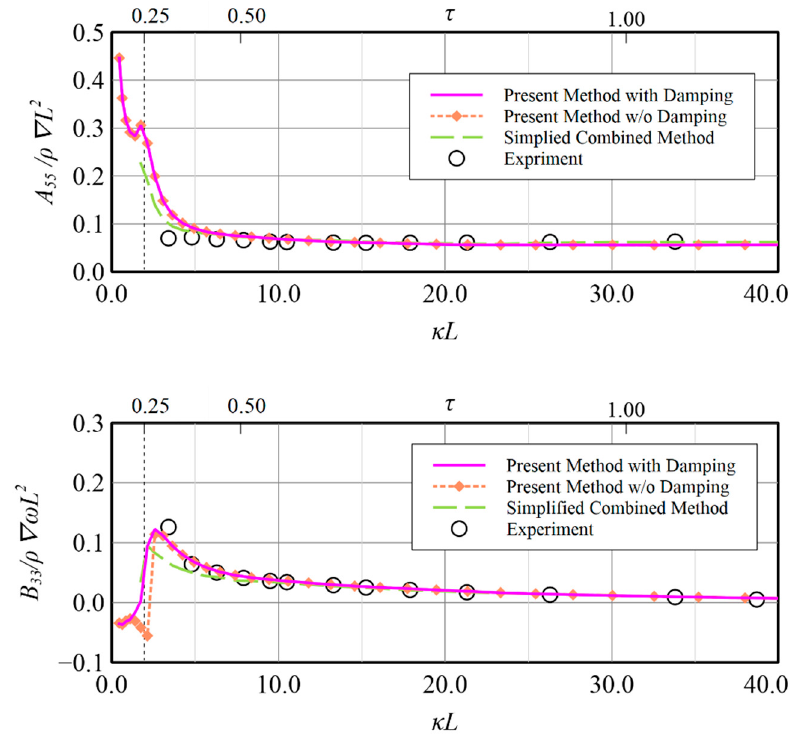
Figure 17. Pitch-induced-pitch added mass and damping coefficient at F r = 0.18.